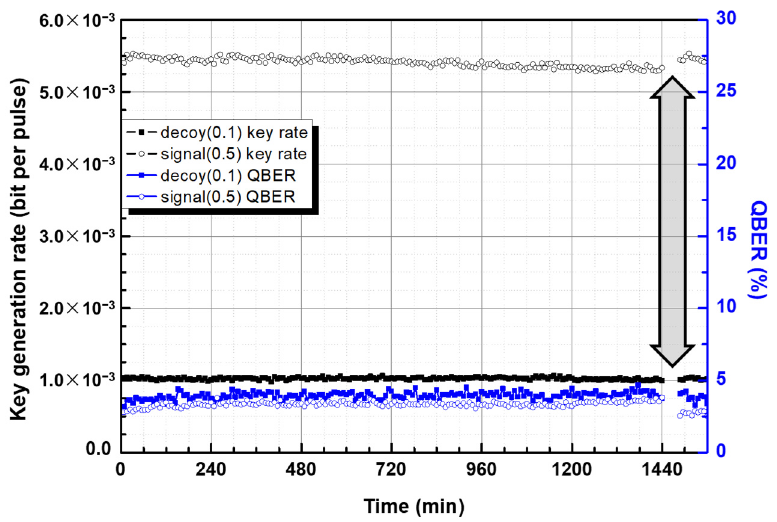
Figure 6. Key generation rate and QBER (signal and decoy) of the proposed PnP QKD. The experiment was conducted for a total of 26 h. After 24 h, the key generation rate and QBER were restored by manual control of the detector’s gate timing. After that, measurements were taken for 2 more hours.